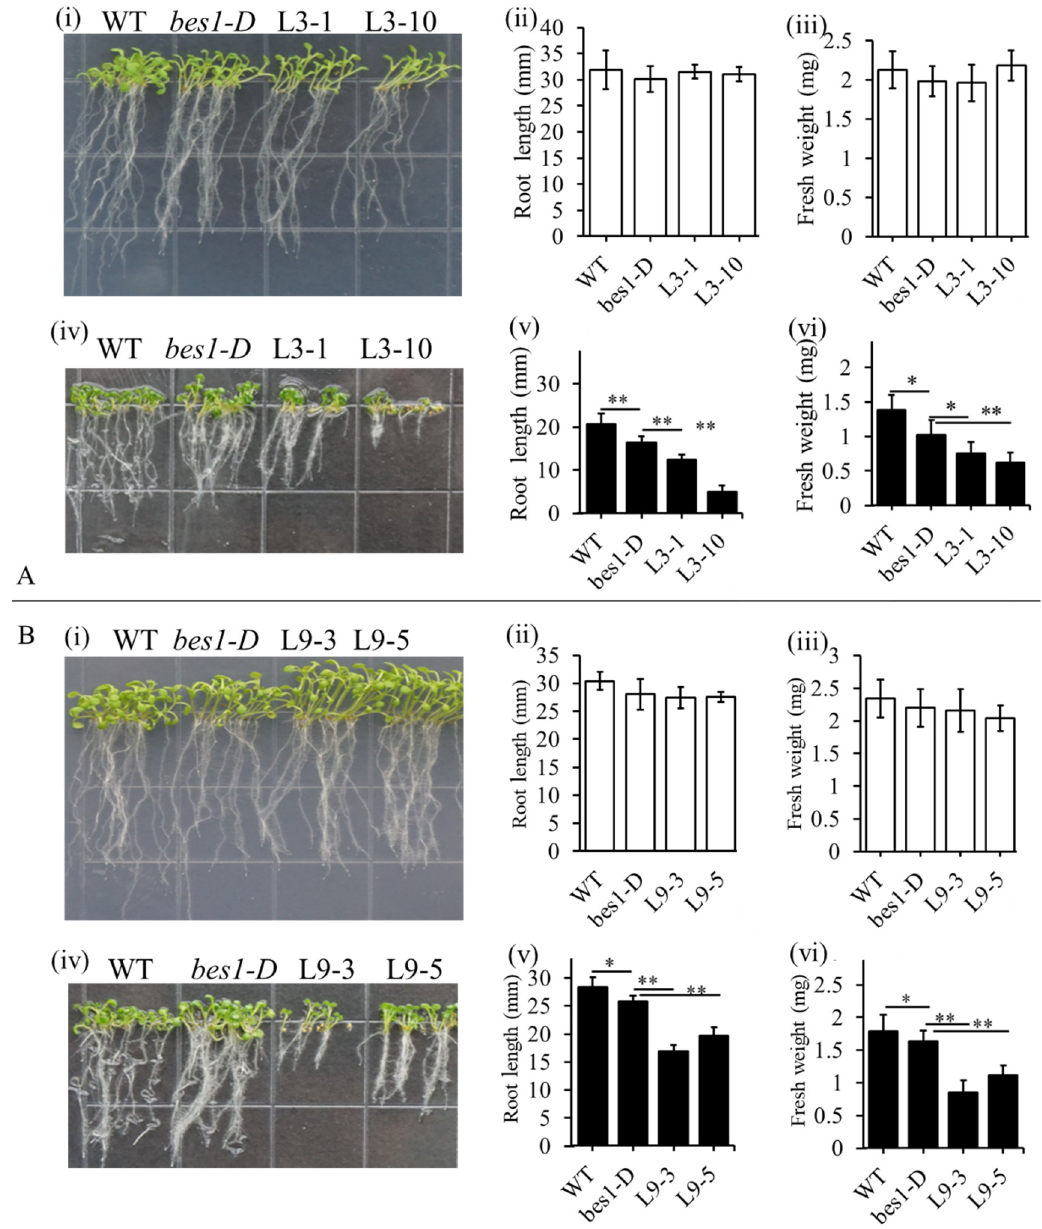
Figure 4. The phenotype of transgenic plants under drought stress mimicking by mannitol. ( A ) Phenotype of ZmBES1/BZR1-3 expressing lines. ( B ) The phenotype of the ZmBES1/BZR1-9 expressing lines. ( i ), ( ii ), ( iii ) The phenotype, root length, and fresh weight of every line on 1/2 MS plates, respectively. ( iv ), ( v ), ( vi ) The phenotype, root length, and fresh weight of every line on 1/2 MS plates with mannitol, respectively. The seeds of every line were surfaced-sterilized, planted on 1/2 MS plates without (control) or with mannitol, and vertically cultured for three weeks. All data are means (±SD) of three biological replicates. L3-1 and L3-10 are homozygous lines expressing ZmBES1/BZR1-3 . L9-3 and L9-5 are homozygous lines expressing ZmBES1/BZR1-9 . bes1-D , untransformed mutant. WT, wild type. * and ** represents p < 0.05 and p < 0.01, respectively.